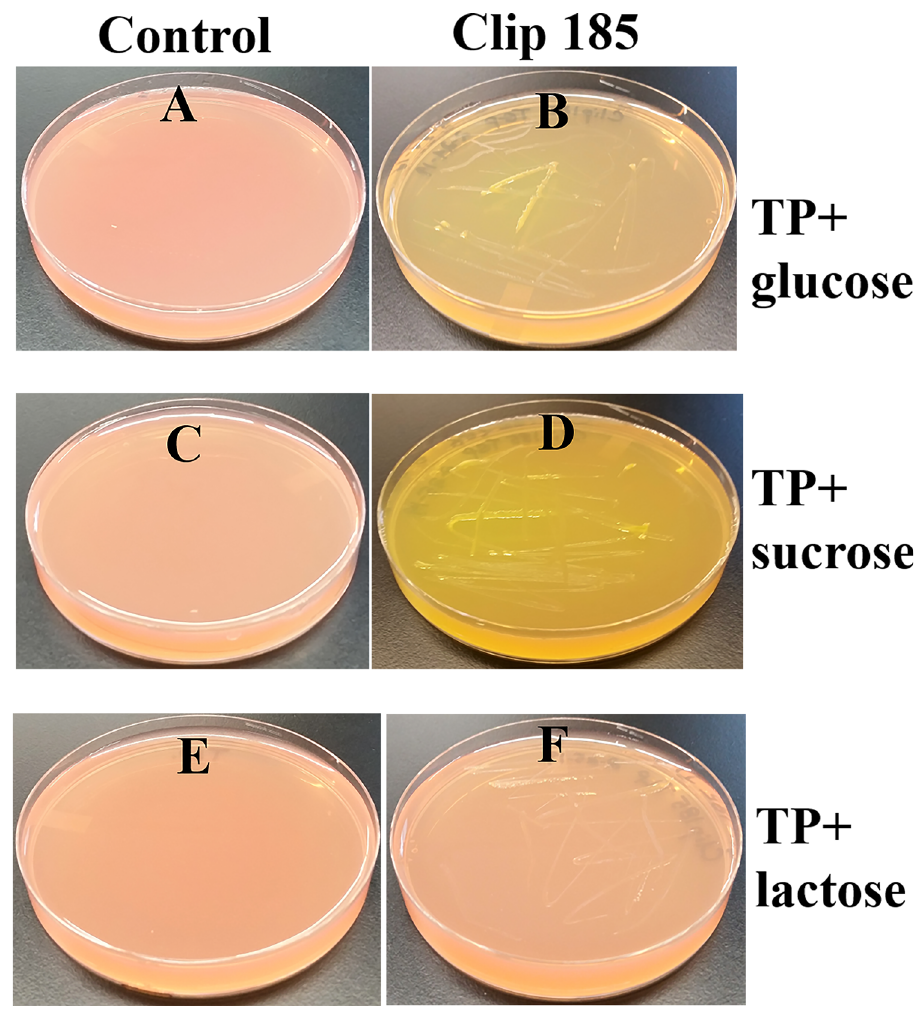
Figure 7. Growth of Clip185 on Tris Phosphate (TP) agar medium supplemented with different sugars. (A) Control TP + 1% glucose agar medium plate with phenol red as a pH indicator. (B) Clip185 on TP +1% glucose agar mediumplatewithphenolredasapHindicator.(C)ControlTP+1%sucroseagarmediumplatewithphenolredasapH indicator. (D) Clip185 growth on TP +1% sucrose agar medium plate with phenol red as a pH indicator. (E) Control TP +1% lactose agar medium plate with phenol red as a pH indicator. (F) Clip185 growth on TP +1% lactose agar medium plate with phenol red as a pH indicator. Culture plates were imaged after 7 days of growth at room temperature.